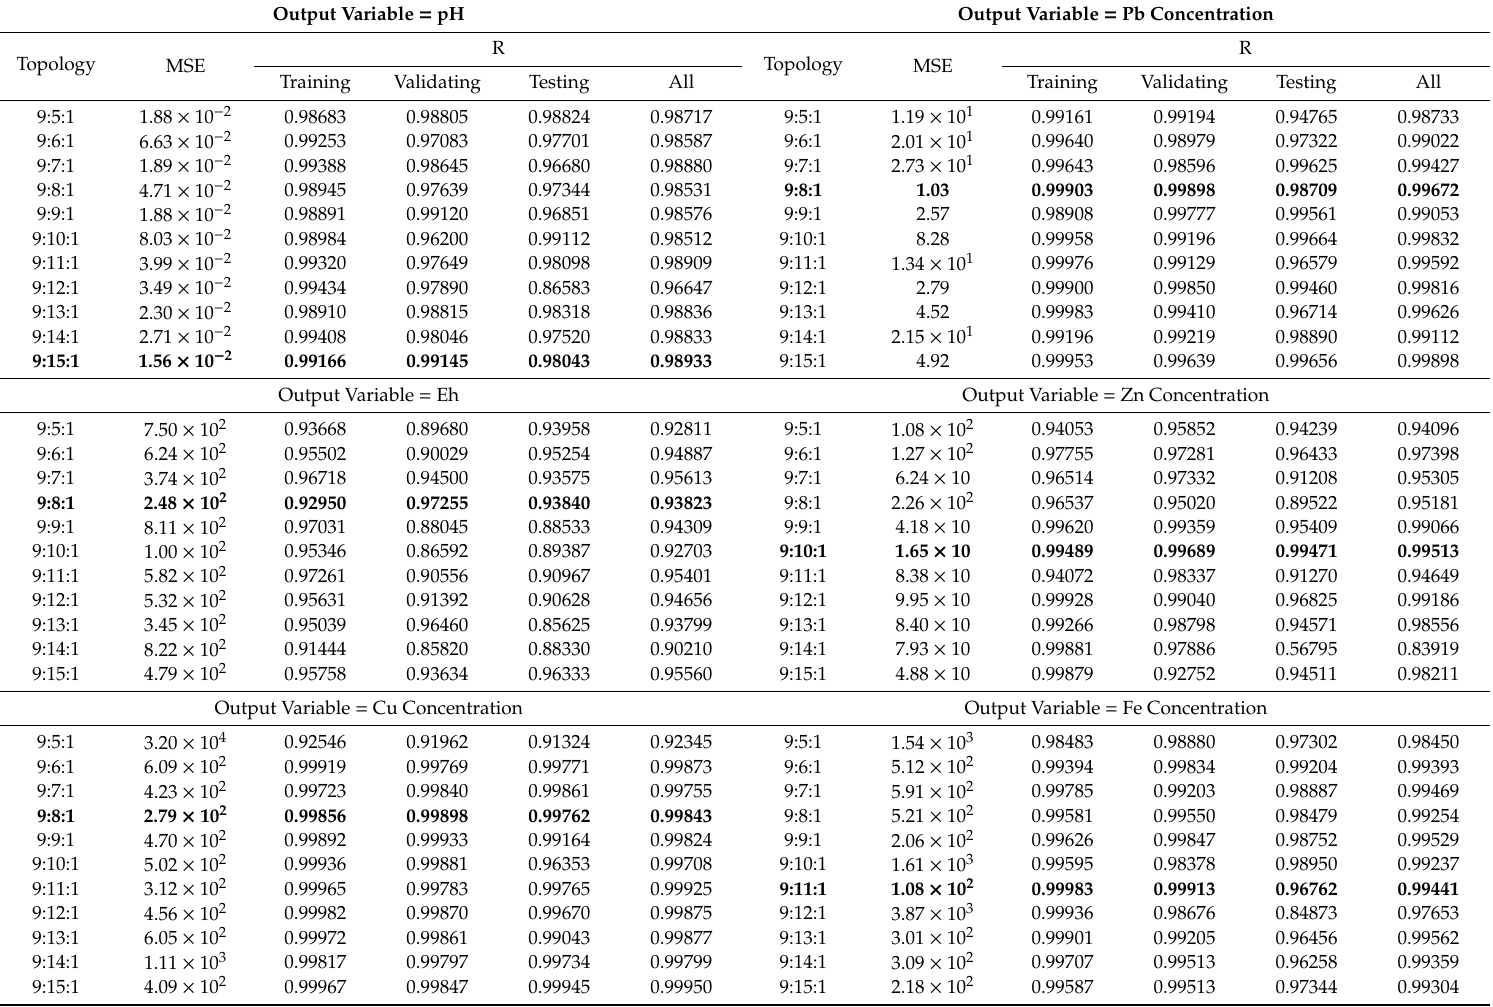
Table 3. Comparison of network topologies with various neurons (bolded is the best